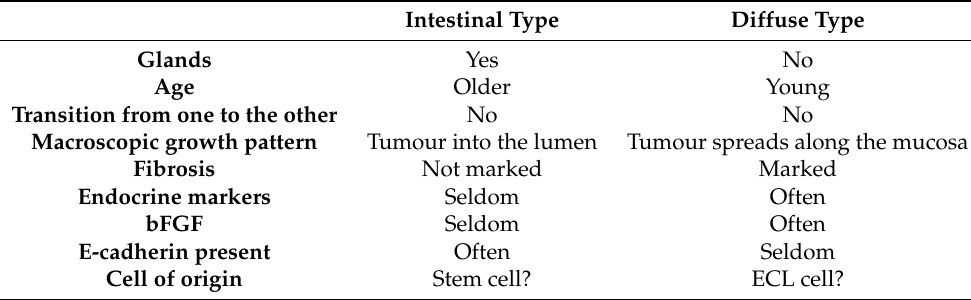
Table 1. Types of gastric